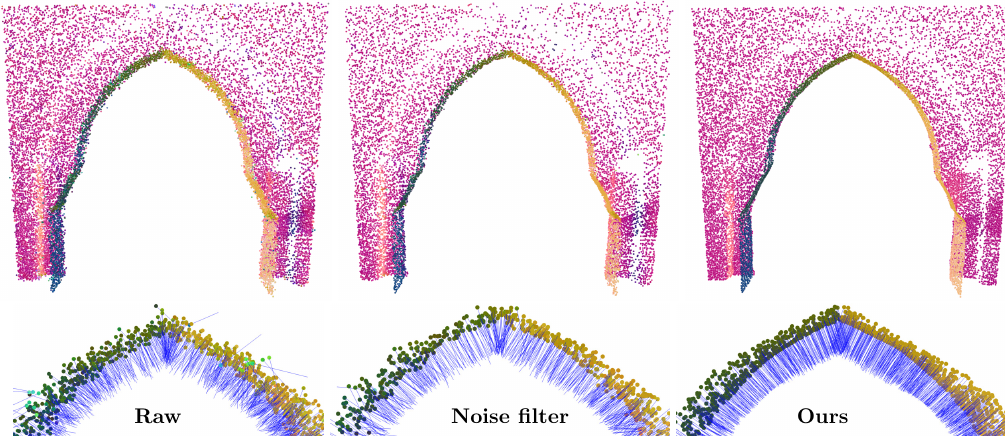
Figure 5. Denoising performed on an trefoil-pointed arch using CloudCompare (v.2.11, 2021) noise filter, and our method. Points are colored by their normals.